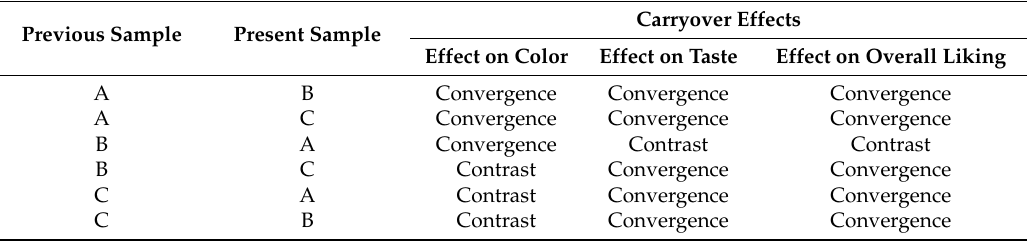
Table 6. Characterization of the carryover effects on three attributes (color, taste, and overall liking) from model